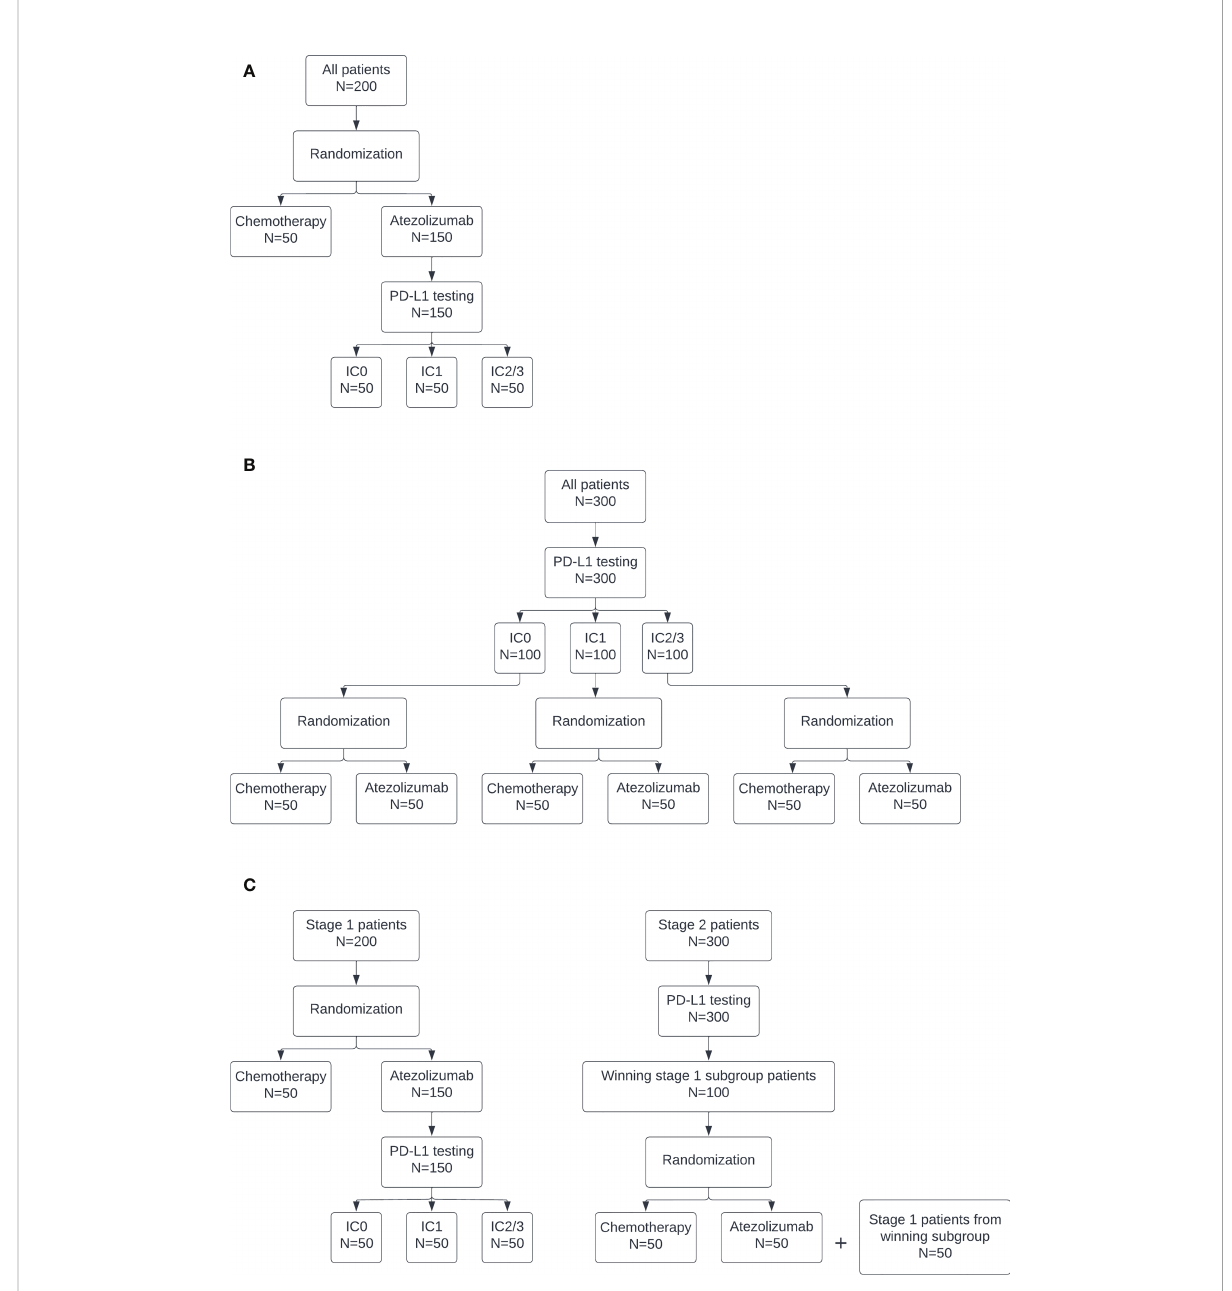
FIGURE 1 Diagrams of the (A) pooled control arm, (B) strati fi ed control arm, and (C) enrichment